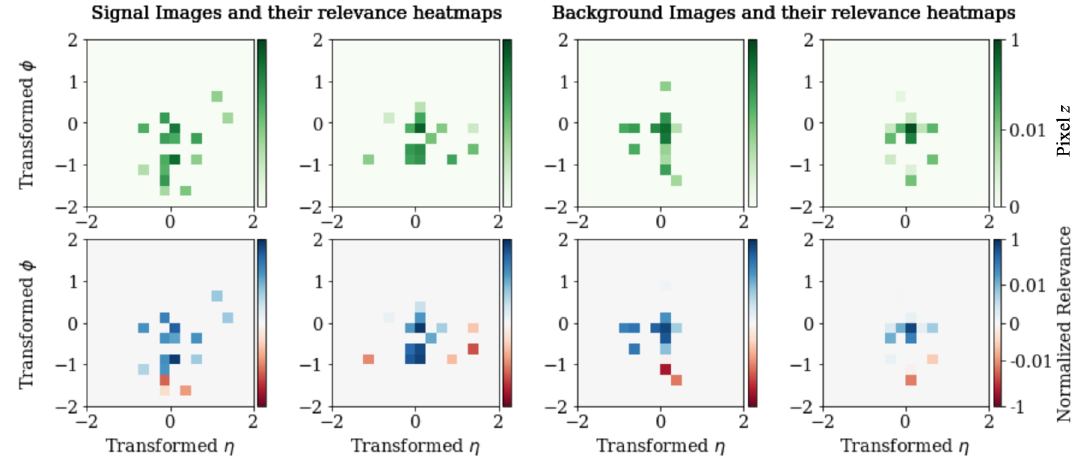
Figure 10. Individual Toy Model signal (left two columns) and background (right two columns) that were correctly predicted (top) and their corresponding LRP score heatmaps (bottom). Features with positive relevance support the prediction for the event, whereas features with negative relevance oppose the prediction for the event. Images are plotted in transformed pseudorapidity-azimuth ( η − φ )